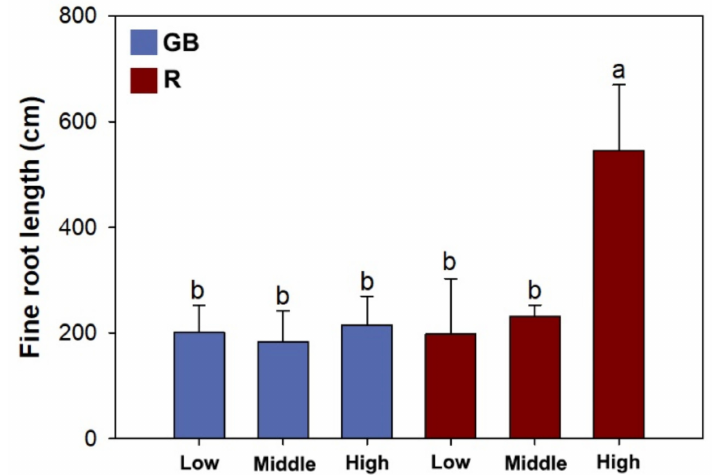
Figure 4. Fine root length in Pinus pumila seedlings subjected to green-and-blue light (GB) and red-light enriched spectra (R) in low, middle, and high half-pot fertilities. Error bars indicate standard deviations. Different letters above bars indicate significant difference according to Duncan test at the 0.05